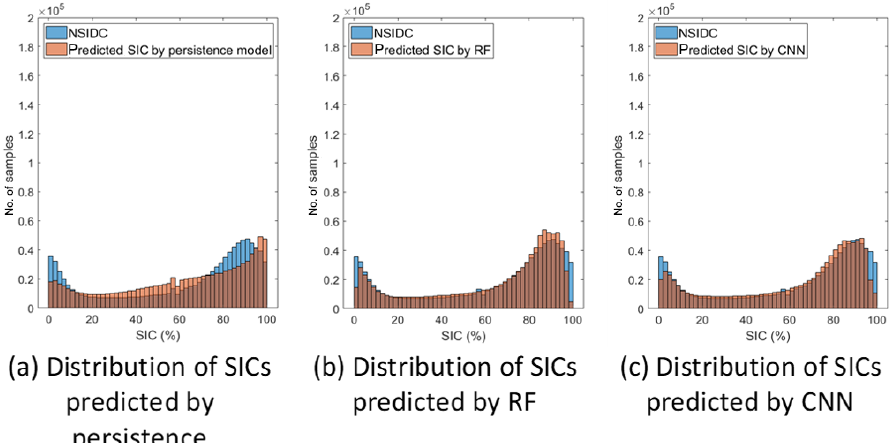
Figure 4. Histograms of SICs based on NSIDC (blue) and three models (brown) in the melting season (June–September) during 2000–2017.